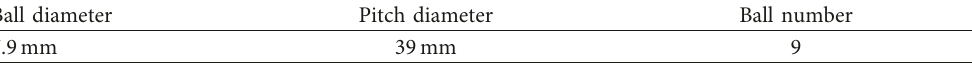
Table 2: SKF6205 bearing parameters.